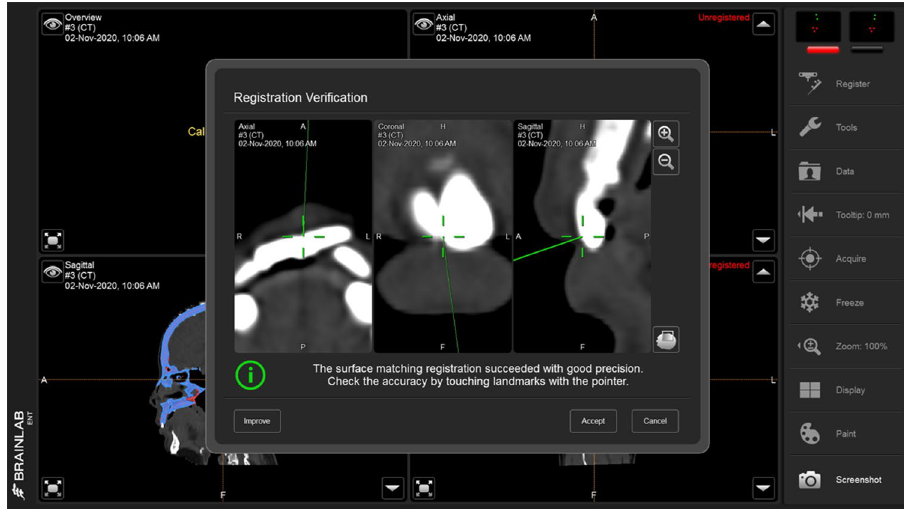
Figure 3. Presurgical verification of the accuracy of reduction. The laser pointer tip was placed on the surface and tip of the upper central incisors as landmarks to determine the precision of the anatomical position in three dimensions. A difference of < 1 mm between the preoperative imaging and the landmarks of the navigation pointer was considered